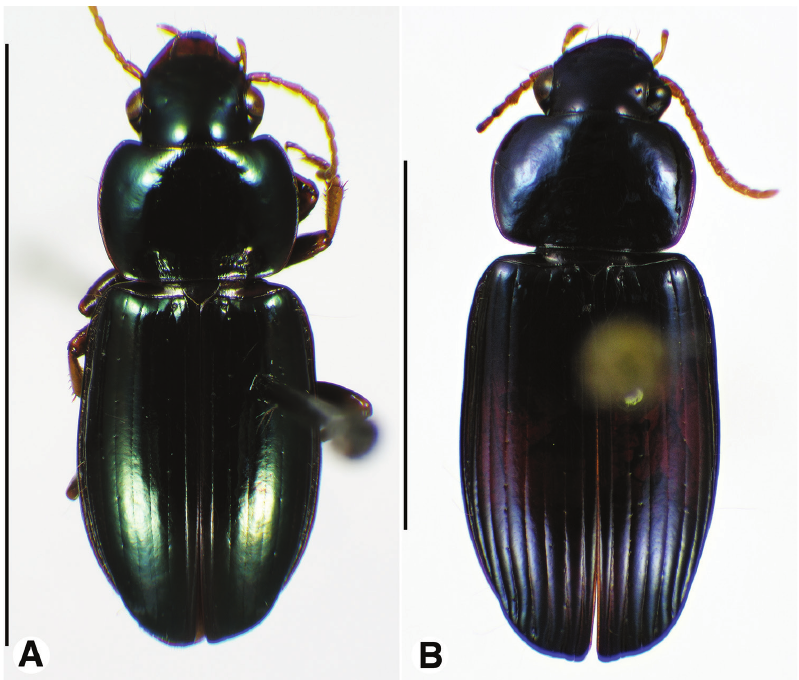
Figure 9. Habitus digital images, dorsal aspect, of Neodiachipteryx species. A N. cariniger (Putzeys) B N. davidsoni sp. n. Scale bars: A 10 mm; B 5